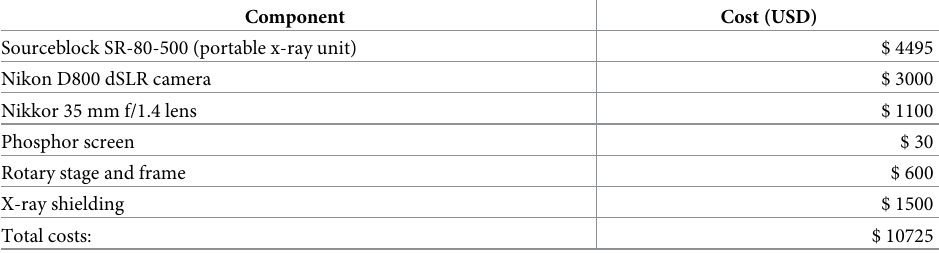
Table 2. Summary of the estimated costs for the main components of the low-cost CT scanner–June